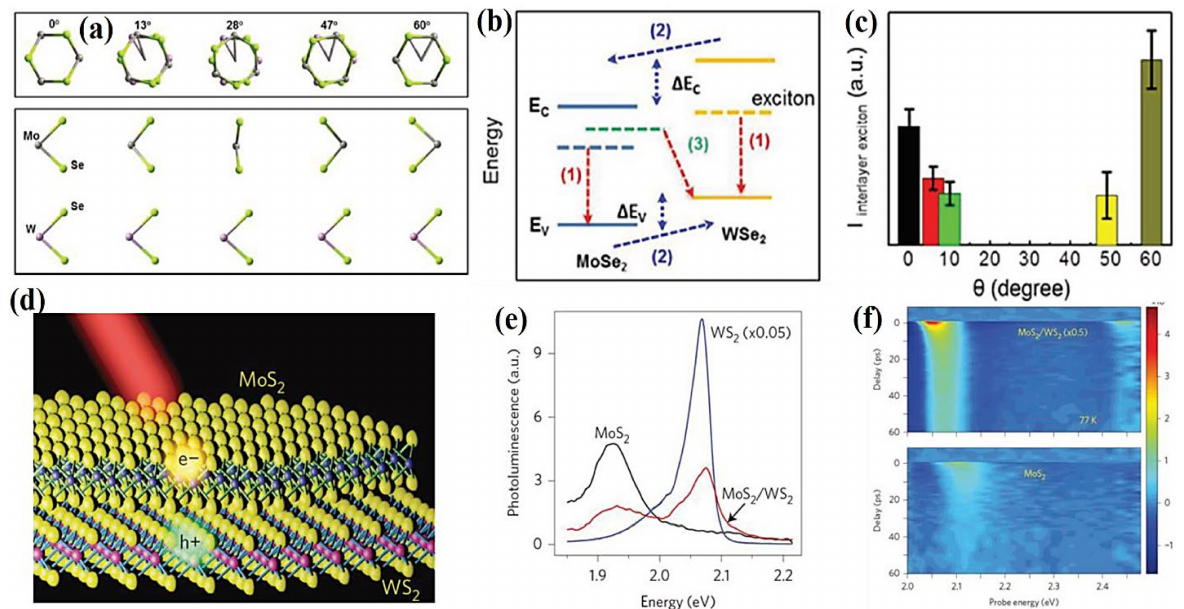
Figure 6. ( a ) Representation of front and lateral views of MoS 2 /WSe 2 heterostructures at varying twist angles. ( b ) Photoexcited excitonic band alignment of MoSe 2 /WSe 2 heterostructures. ( c ) Inter- layer exciton peak intensity as a function of twist angle. Adapted with permission from Ref. [108]. Copyright 2017, American Chemical Society. ( d ) Atomistic representation of heterostructures based on MoS 2 /WS 2 . ( e ) PL spectrum of isolated MoS 2 , WS 2 , and heterostructures based on MoS 2 /WS 2 . ( f ) 2D plots of transient absorption spectra from a MoS 2 /WS 2 heterostructure at 77 K(top); and an isolated MoS 2 monolayer (down) upon excitation of the MoS 2 A-exciton transitions. Probe photon energy, probe-pump time delay, and transient absorption signal are shown by a horizontal axis, a vertical axis, and a color scale, respectively. Whereas the pump-induced decrease in absorption is indicated by positive signals. Adapted with permission from Ref. [92]. Copyright 2014,